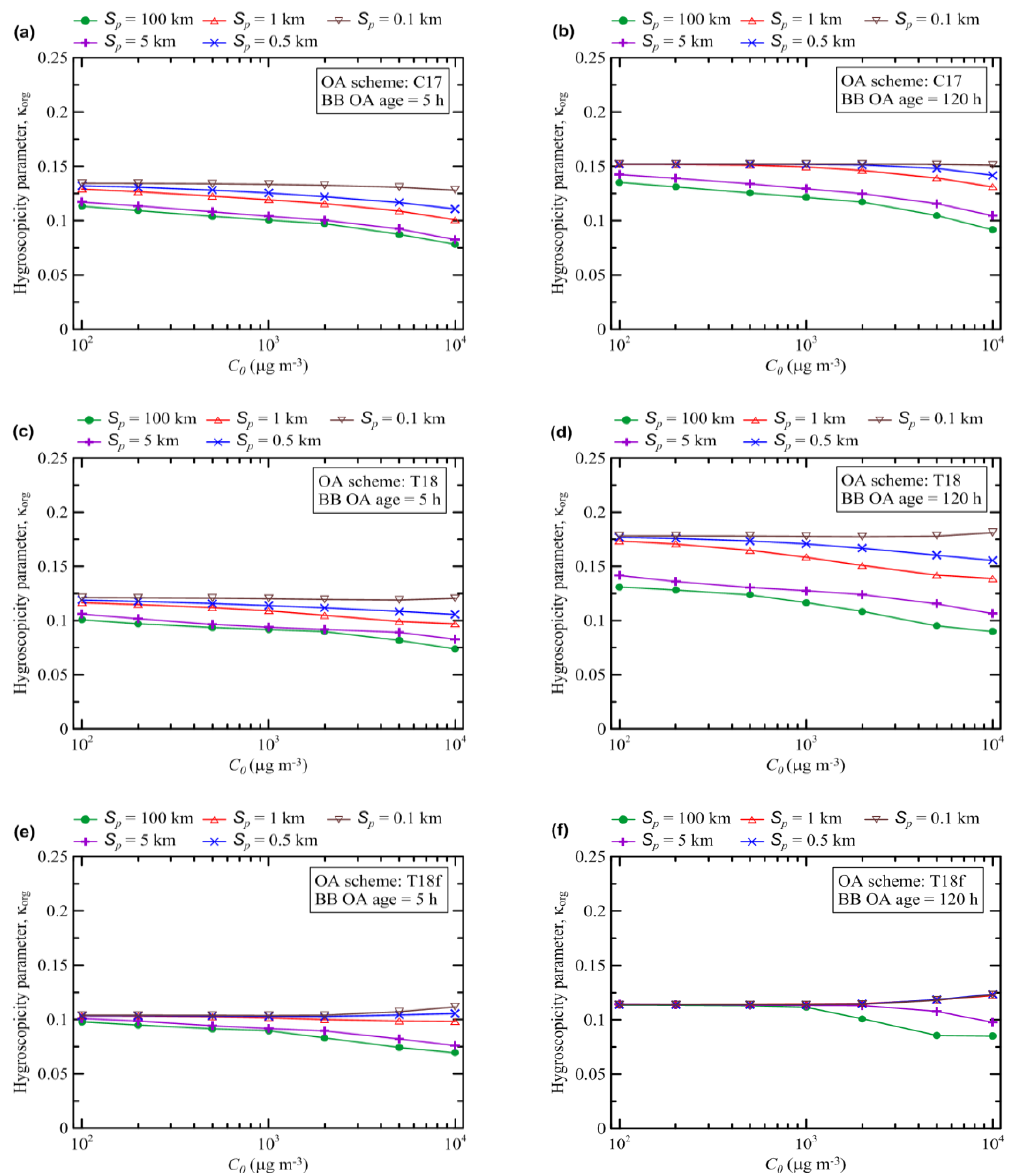
Figure 8. Dependencies of the hygroscopicity parameter, κ org , after (a, c, e) 5h and (b, d, f) 120h of BB OA evolution, simulated using the (a, b) C17, (c, d) T18, and (e, f) T18f